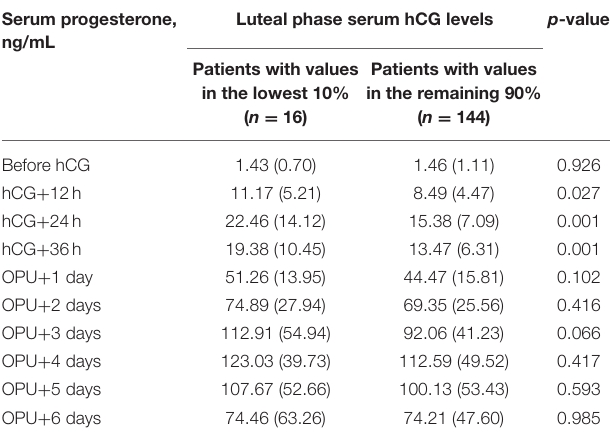
TABLE 3 | Early luteal phase serum progesterone levels in subjects with the lowest 10% of early luteal phase human chorionic gonadotropin (hCG) values vs. patients with luteal phase hCG levels in the remaining